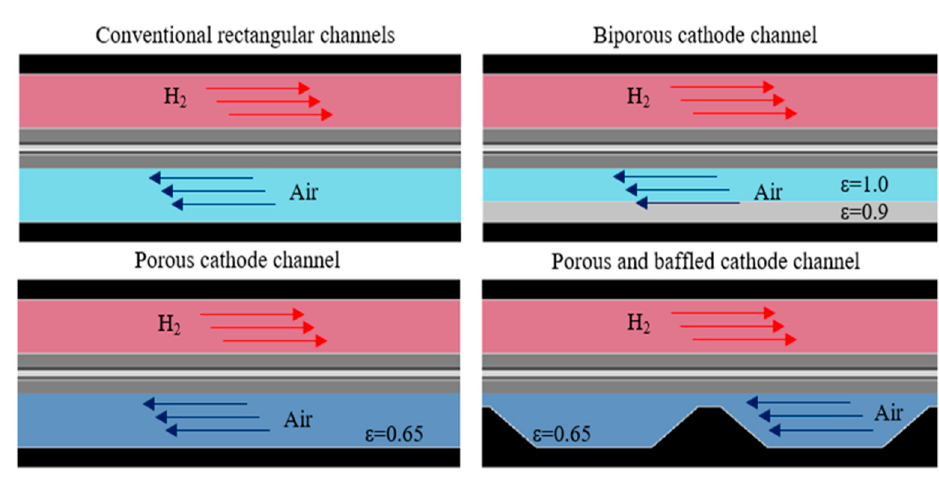
Figure 1. Flow field configurations.